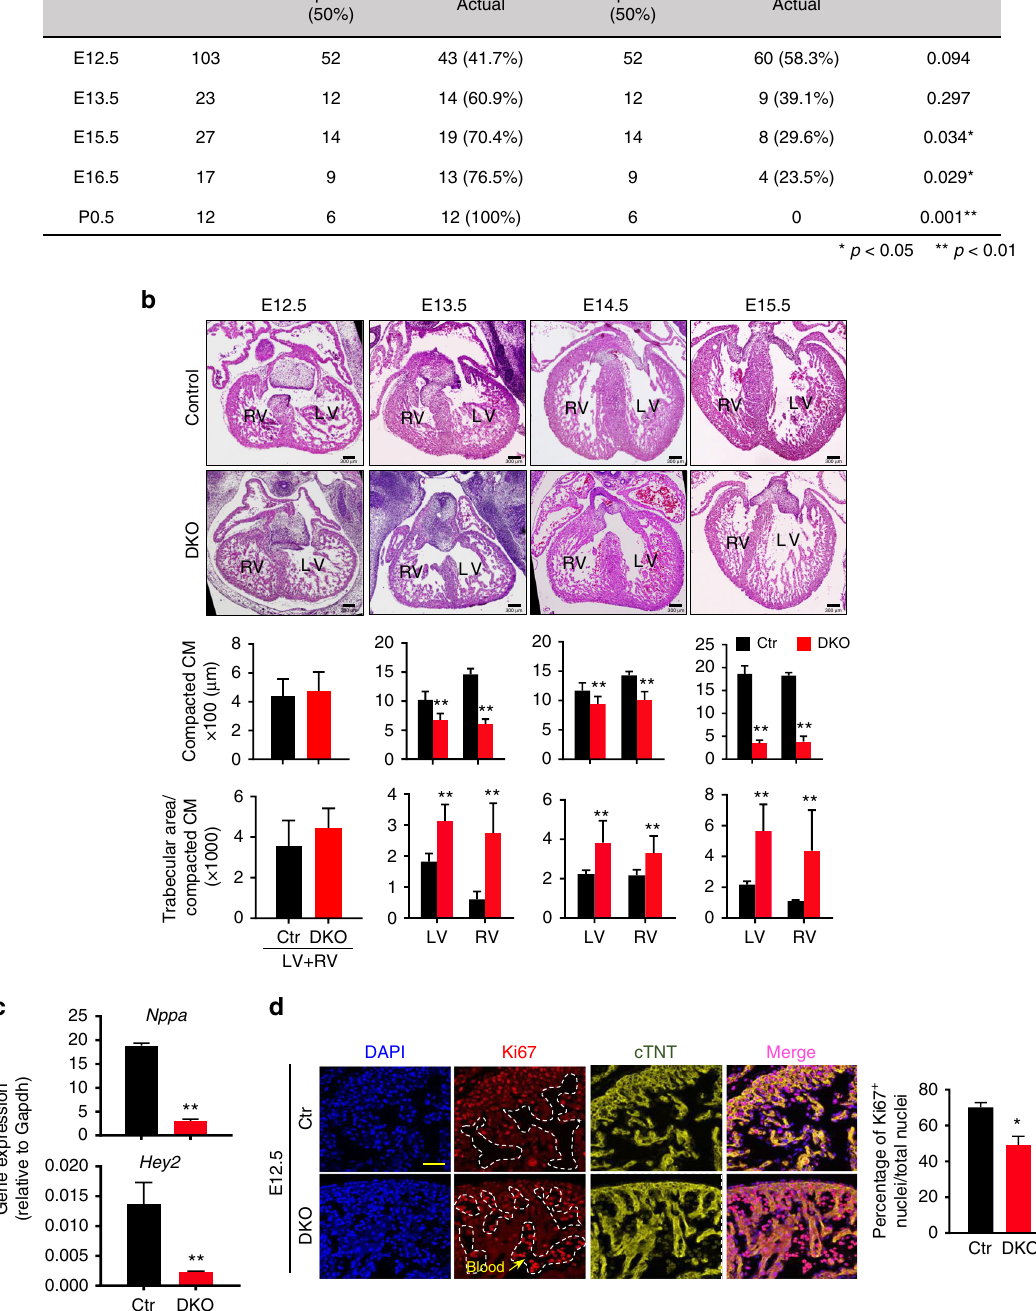
such as Nppa and Hey2 , were signi fi cantly down-regulated in E15.5 Tet2/3-DKO CMs when compared to controls (Fig. 3e). Furthermore, genes essential for cardiac development, such as Tbx20, Ttn and Gja1 , were signi fi cantly down-regulated in Tet2/ 3-DKO E15.5 CMs (Fig. 3e). both control and Tet2/3-DKO mice using the MAGIC algo- rithm 39 . In the CMs marked by Ttn , we found that Tet2/3